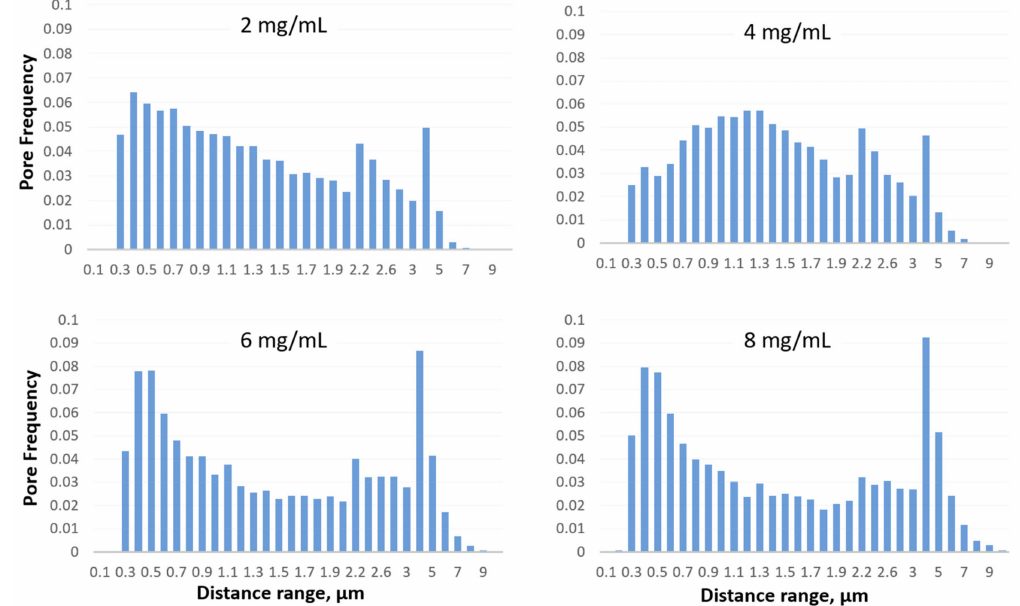
Figure 6. Pore spatial distribution of gold film at di ff erent GO